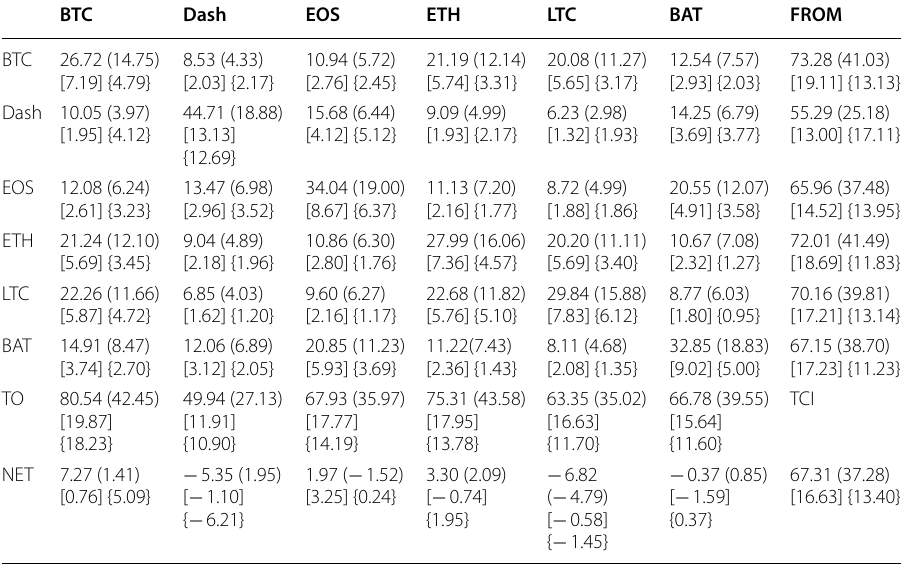
The values in parentheses (), square brackets [], and curly brace {} denote the short‑term (1–5 days), medium‑term (5–22 days), and long‑term (more than 22 days) frequency connectedness results